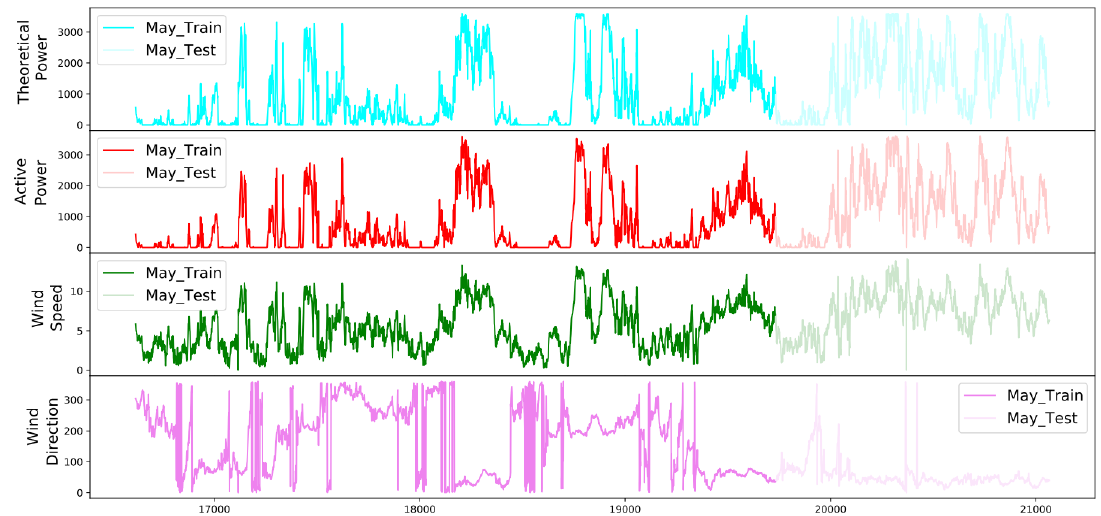
Figure 13. The theoratical power, active power, wind speed, and wind direction for one month of train, and